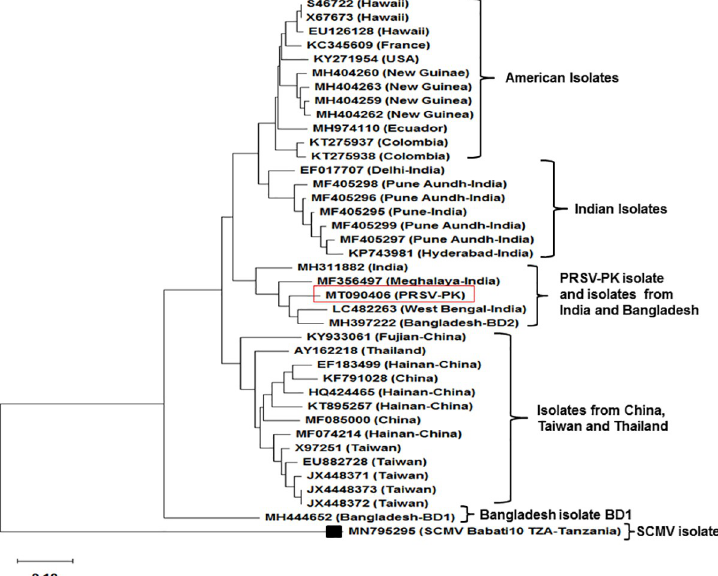
Fig 3. Region-specific maximum-likelihood tree representing the phylogenetic relationship between complete genome sequences of PRSV-P isolate of Pakistan and PRSV complete genome sequence from rest of the world. Sugarcane mosaic virus (SCMV) (accession no. MN795295) used as an outgroup. The tree was constructed using ClustalX2 and MegaX Program. The scale bar represents nucleotide substitution per site, the bootstrap value of